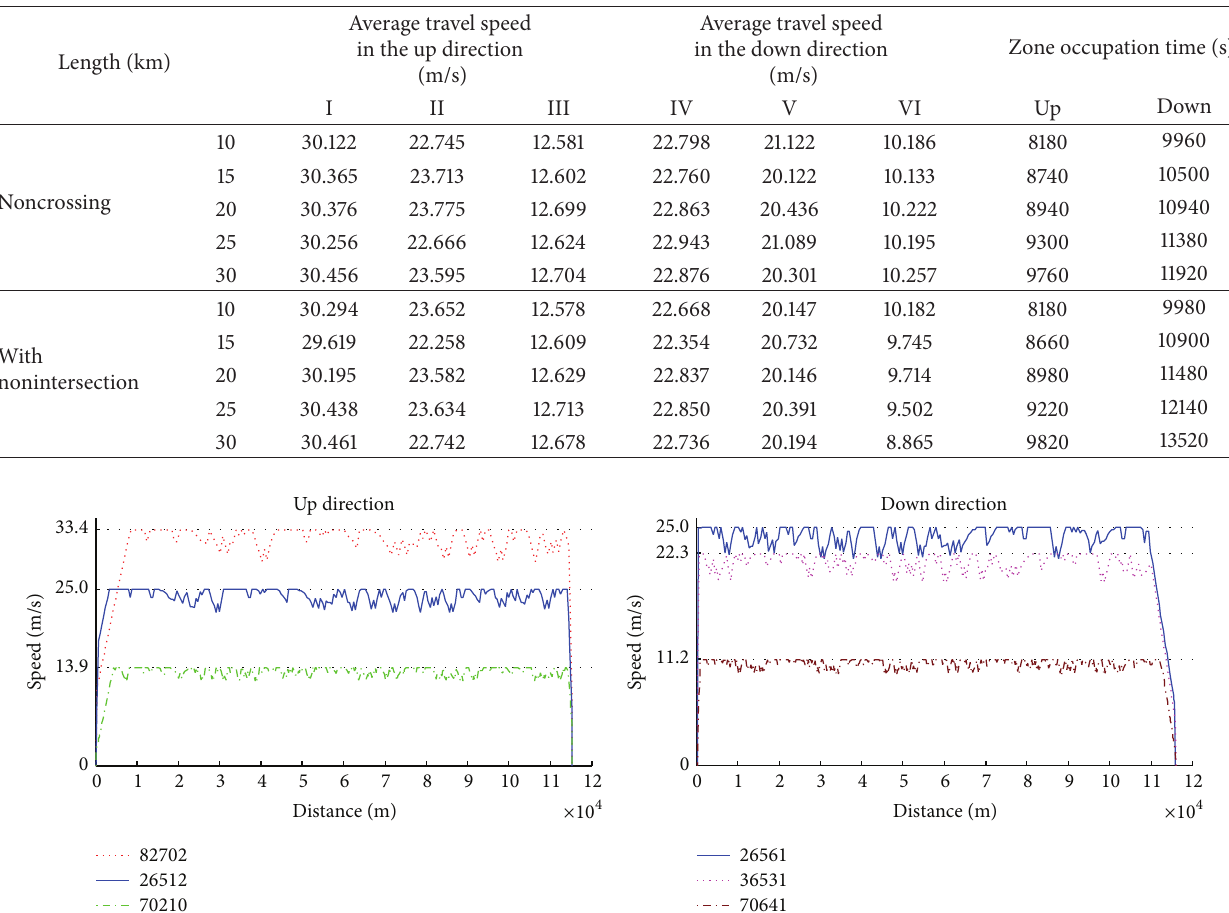
Table 3: Results for different NCBSs setting length.